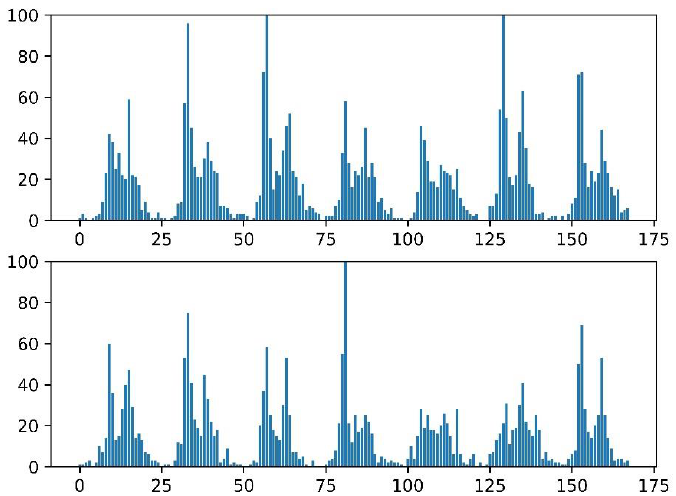
Figure 7. Cycle features of traffic violations by comparing the number of traffic violations per hour in two random weeks.